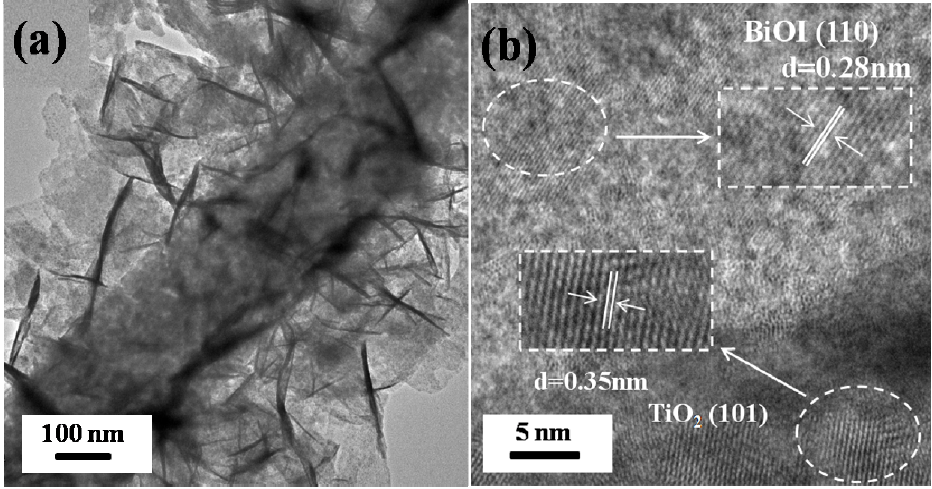
Figure 2. ( a ) TEM; and ( b ) HRTEM images of BiOI/TiO 2 ‐ C30.